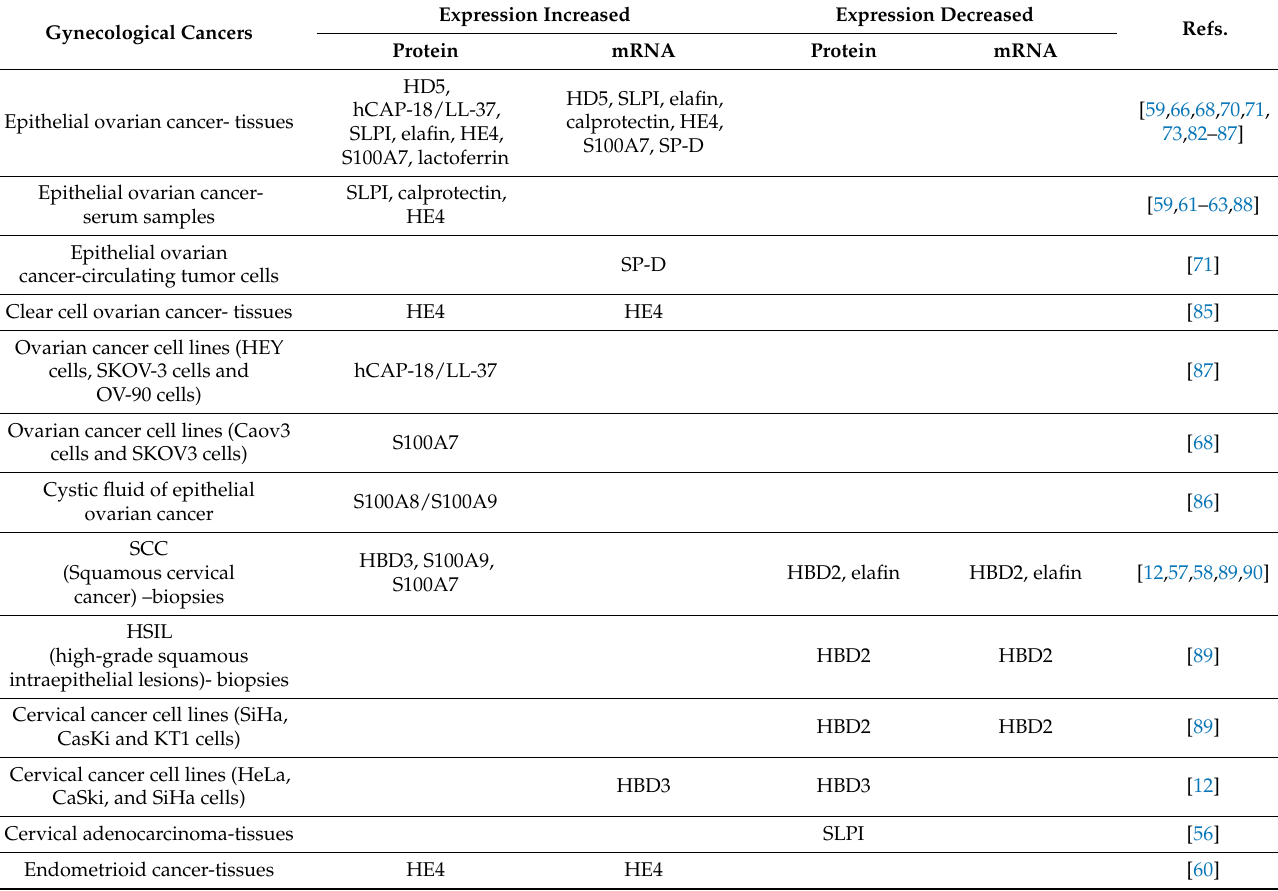
Table 2. AMP expression in gynecological